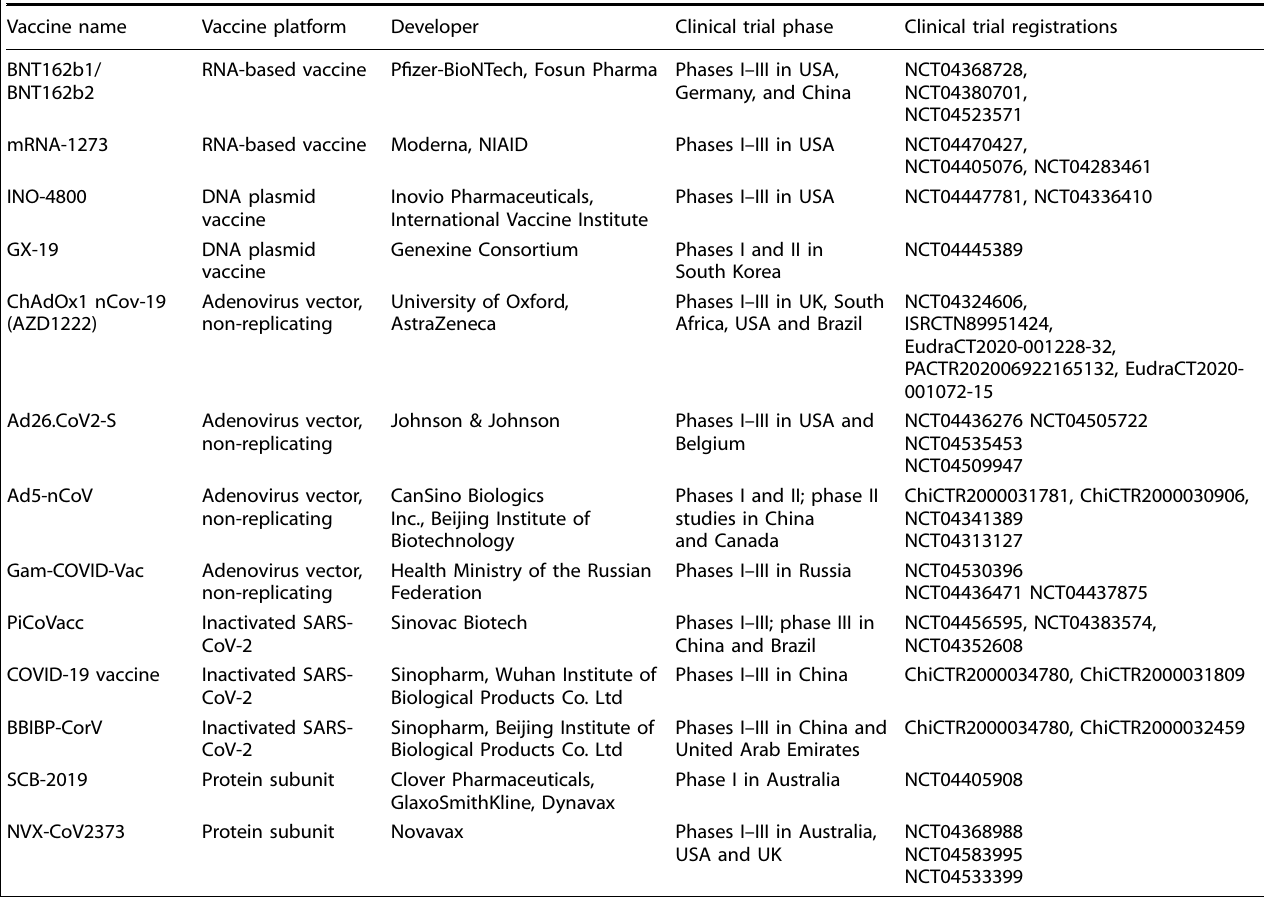
Table 1. Major CoVID-19 candidate vaccine platforms in clinical